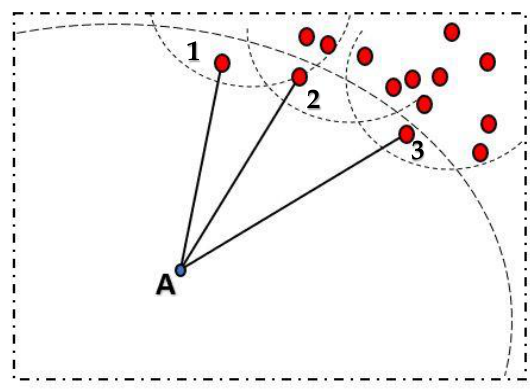
Figure 4. Illustrating basic concept of LOF.